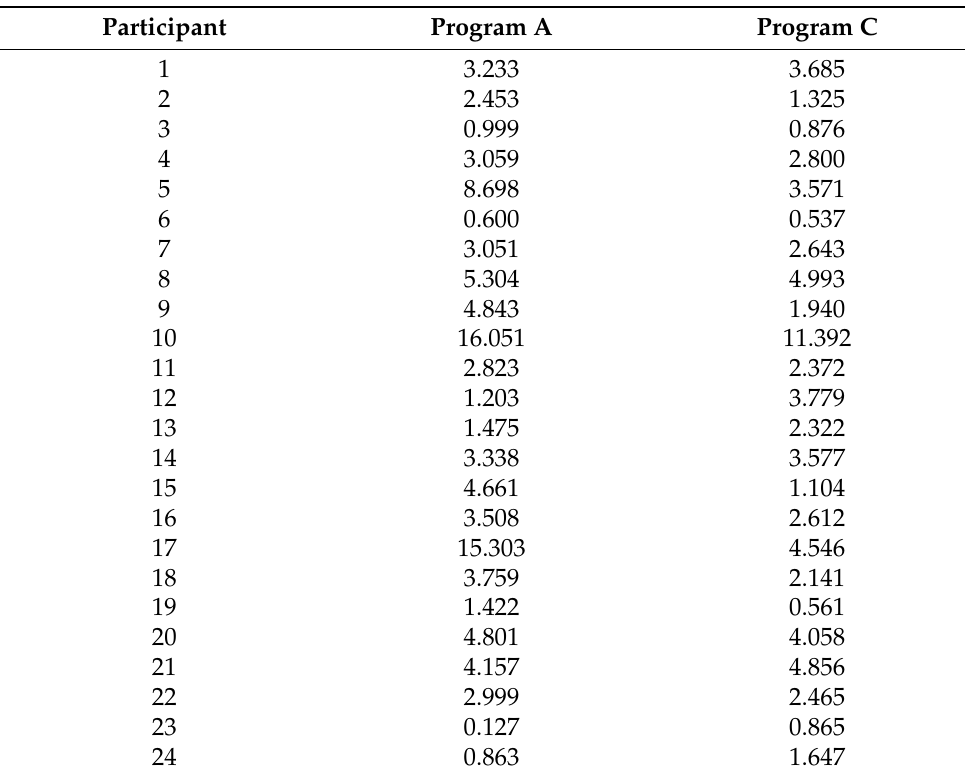
Table 5. T/B for 24 participants in Experiment